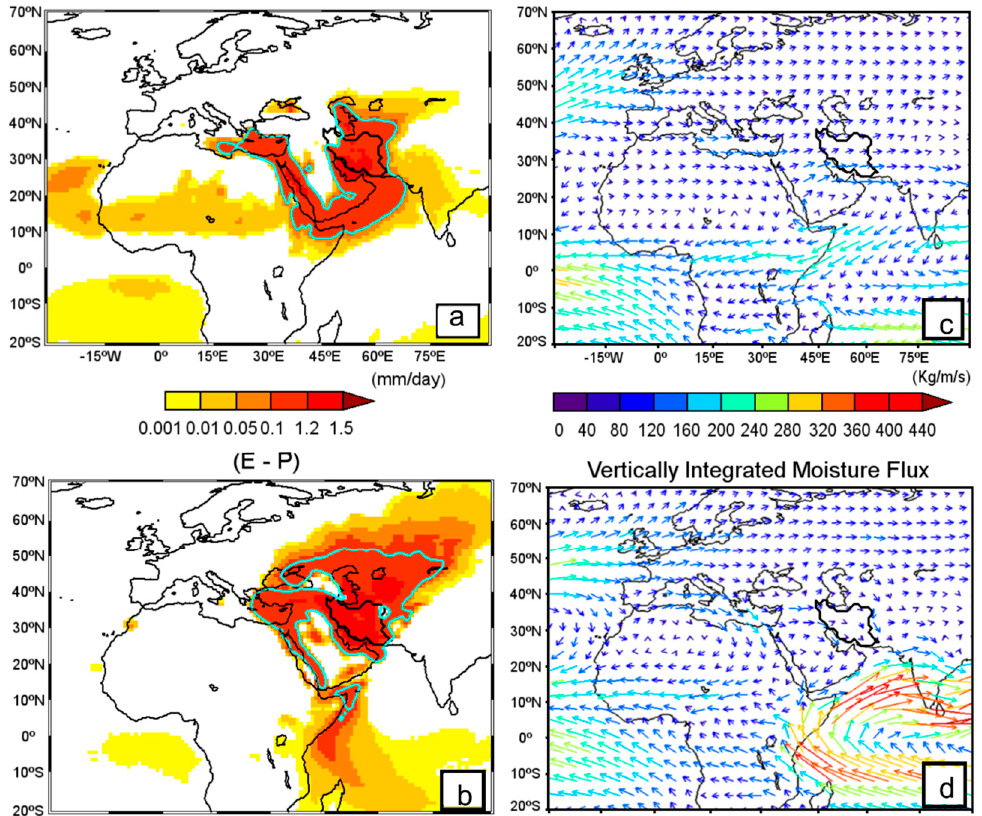
Figure 2. Seasonal pattern of (E-P) > 0 (mm/day) backward integrated from Iran along 10 days for wet (November to April) ( a ) and dry (May to October) ( b ) seasons. The light blue line (p95 value) shows the boundaries of the sources and vertically integrated moisture flux (vectors in kg m − 1 s − 1 ) for wet ( c ) and dry ( d ) seasons (data obtained from ERA-Interim).